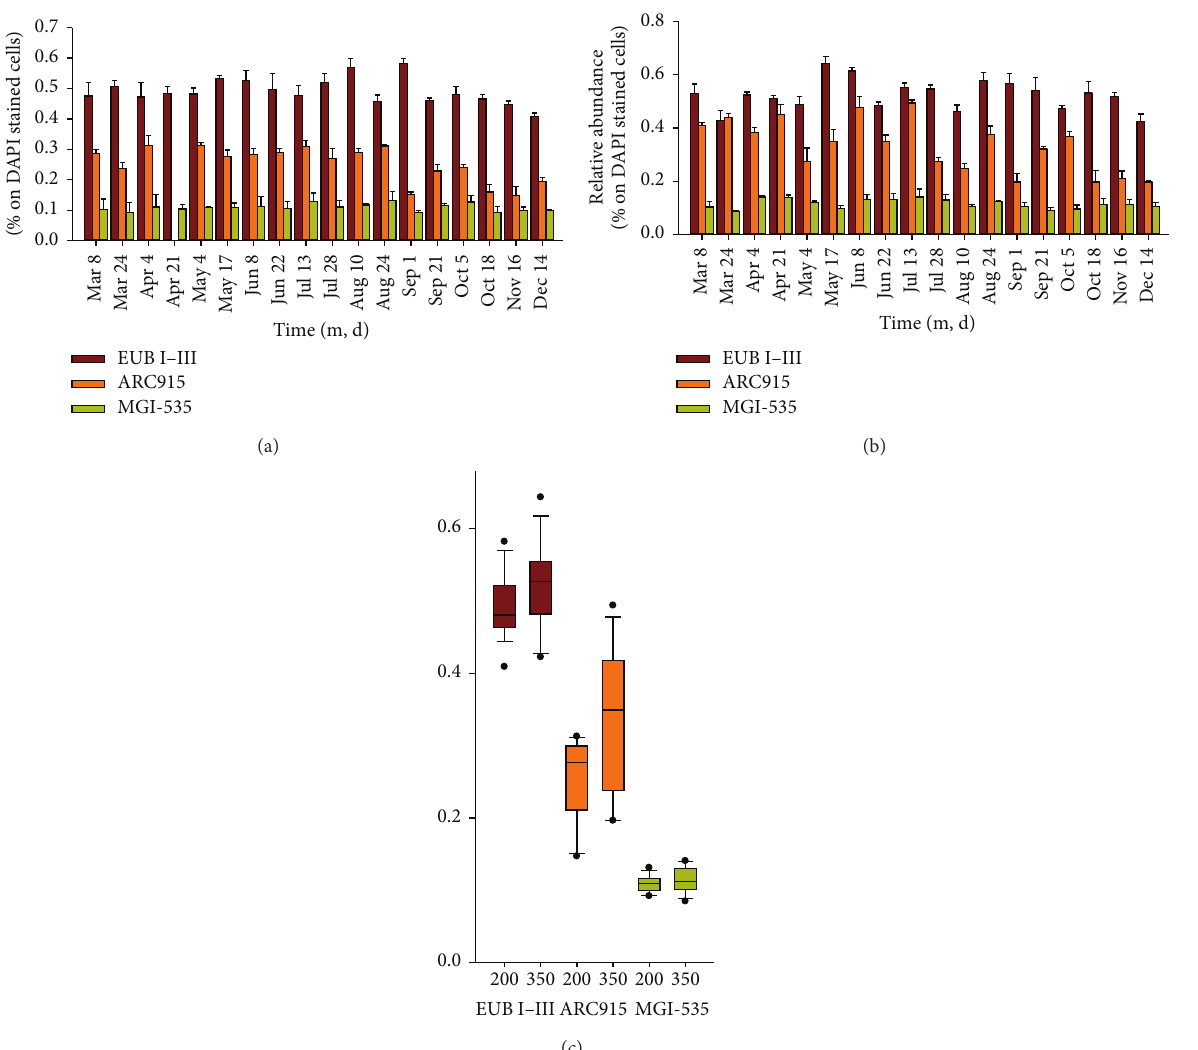
Figure 3: Relative proportions ( ± s.d.) of hybridized cells in Lake Maggiore in 2011 (Ghiffa sampling station) for Bacteria (probe EUB I–III), Archaea (probe ARC915), and Thaumarchaea of the Marine Group I (probe MGI-535) at 200 m (a) and 350 m (b). Boxplot of hybridization rates (c) for the same samples (Ghiffa station, 2011). Whiskers indicate Tukey’s 1.5 IQR. Significant differences in mean between 200 m and 350 m were detected for ARC915 ( 𝑝 < 0.01 ) and EUB I–III ( 𝑝 = 0.05